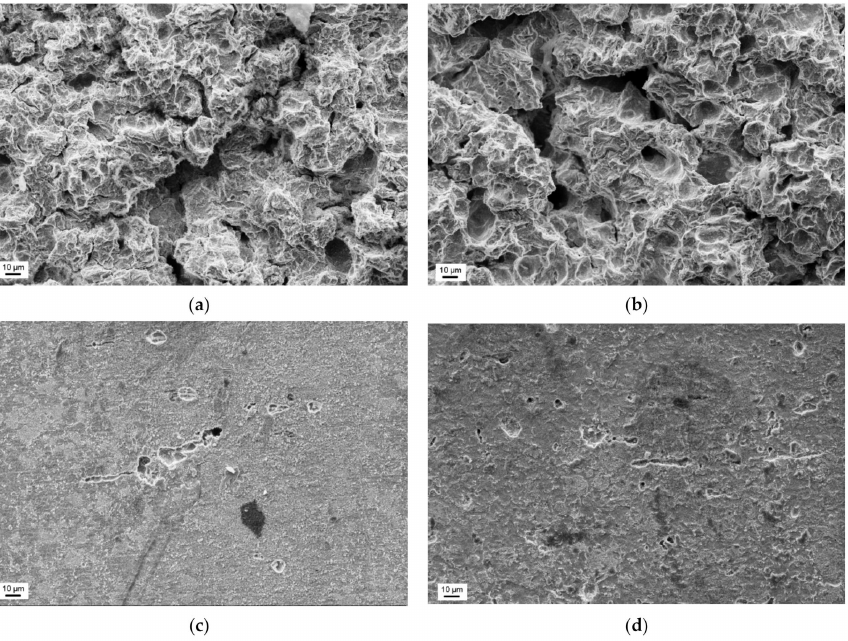
Figure 16. Surface damages developed during cavitation erosion tests carried out at a flow velocity of 35 m/s in the high erosion zone of ( a ) S235JR-AR steel and ( b ) S235JR-TT steel, and in the low erosion zone of ( c ) S235JR-AR steel and ( d ) S235JR-TT steel.